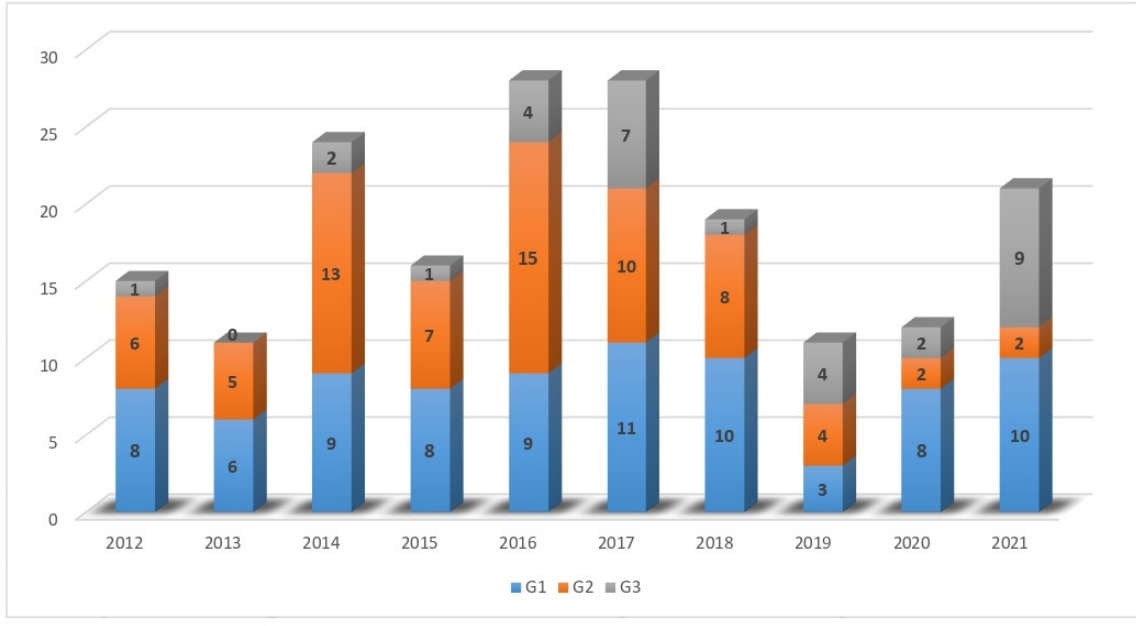
Figure 2. Distribution of selected studies by year of publication and the three category Groups (2012–2021) .